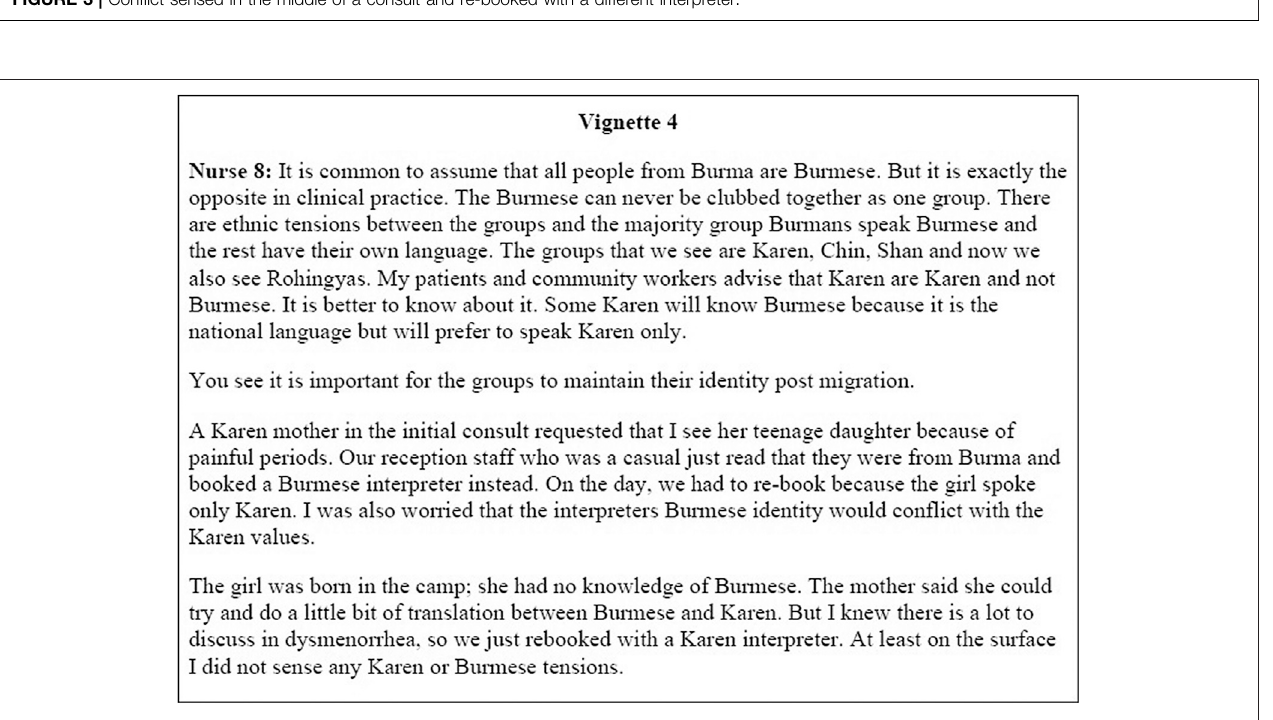
FIGURE 3 | Con fl ict sensed in the middle of a consult and re-booked with a different interpreter.